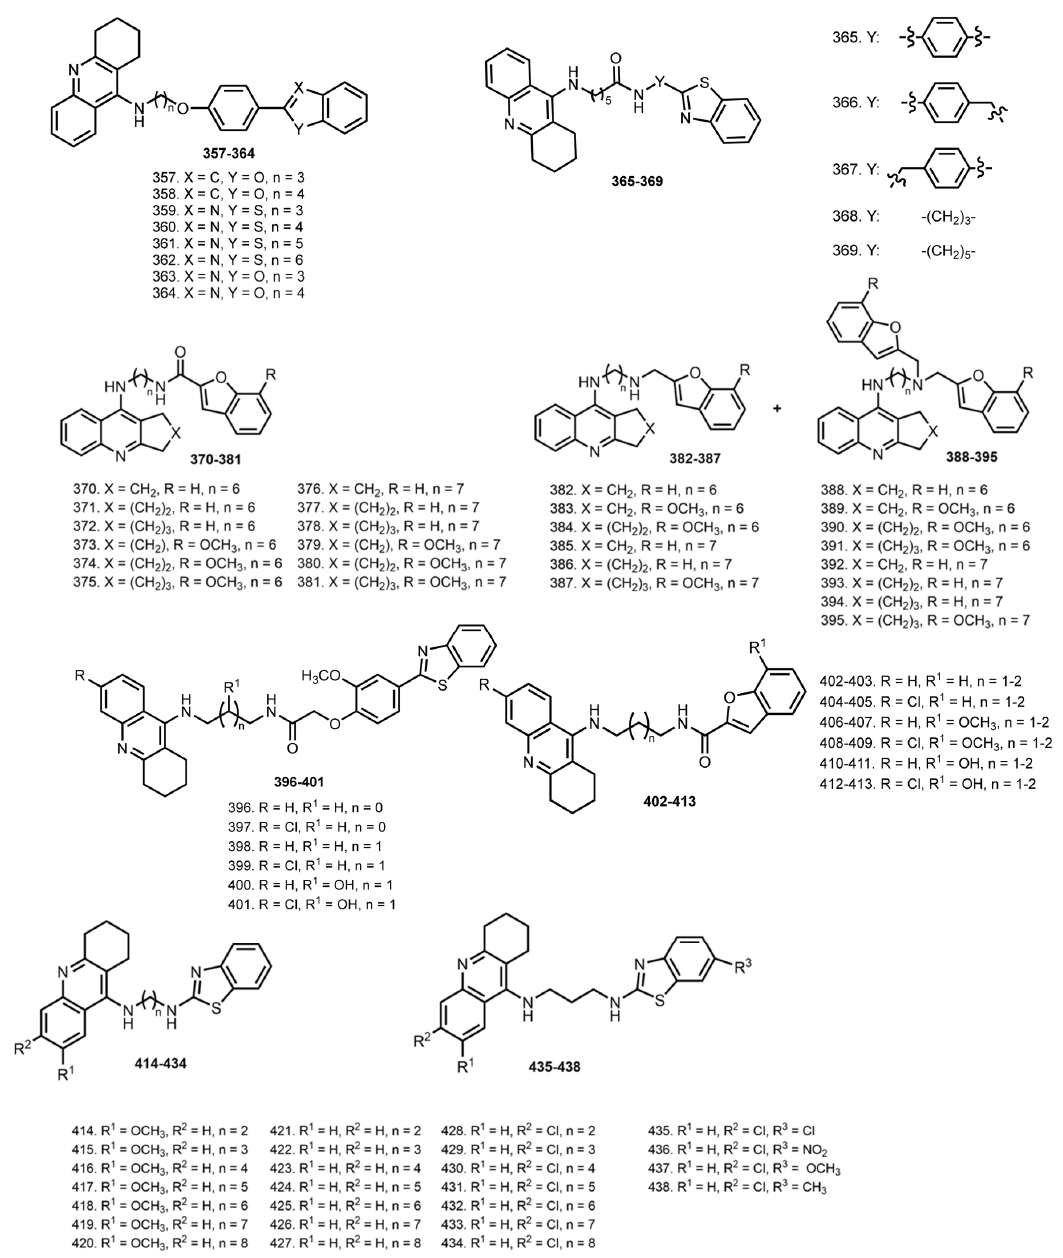
Figure 13. THA–benzofuran 357 and 358 and THA–benzotiazole hybrids 359 – 364 [68], THA–benzo